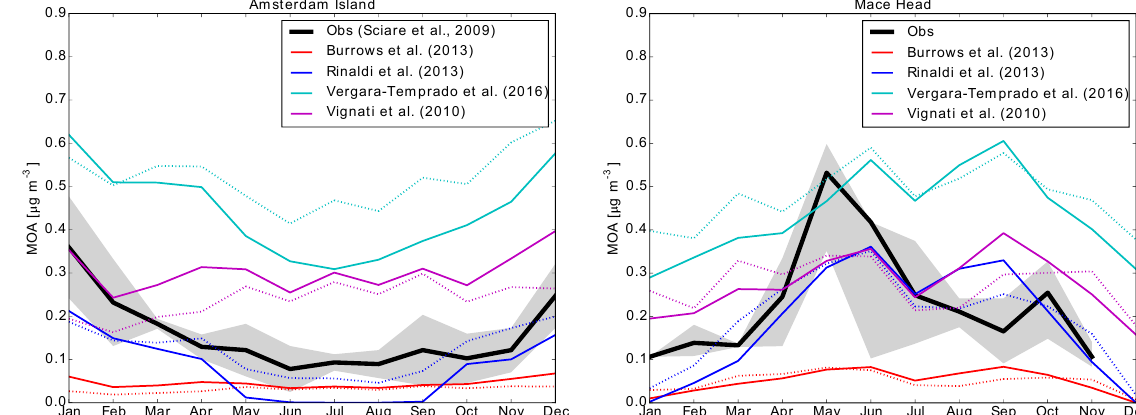
Figure A1. Comparison of MOA concentrations calculated offline using various OMF parameterisations. Coloured lines indicate offline calculated concentrations assuming the same source regions as the observational datasets; dotted lines of the same colours correspond to the same parameterisations except for the use of source regions from Vergara-Temprado et al. (2017). The black lines and shaded areas are the observational mean and the corresponding variances as described in Fig.